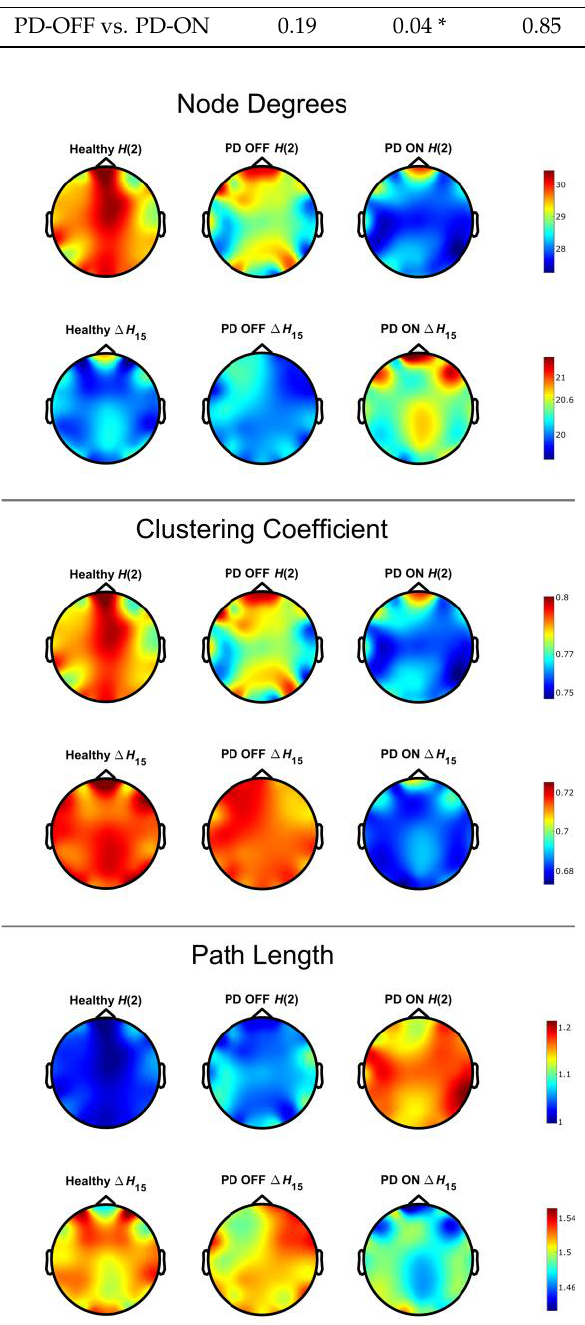
Figure 2. Distribution of the network metrics in the cortex. HC: healthy control, PD OFF: Parkinson’s disease patients off medication, PD ON: Parkinson’s disease patients on medication.